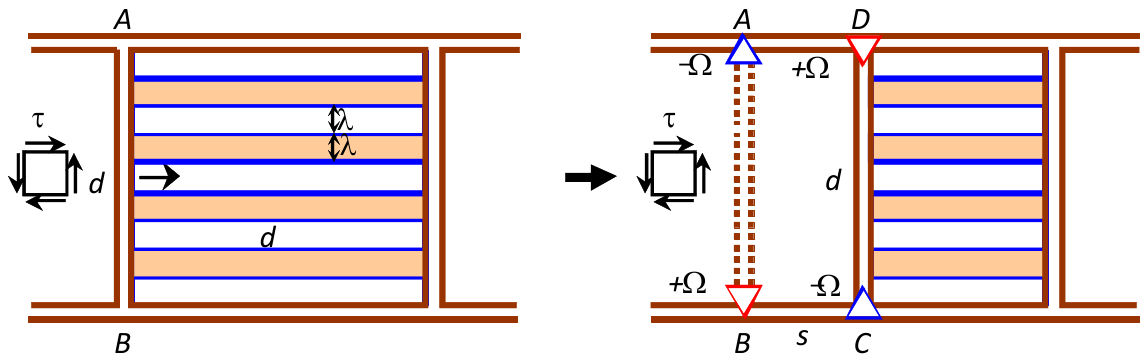
Fig. 1. Model of the stress-driven GB migration accompanied by the twin boundary migration in ultrafine- grained materials with nanotwinned structure. (a) An initial defect configuration containing high-angle GB AB and nanoscale twins which adjoin the GB AB . (b) Migration GB AB to a distance s in a new position CD